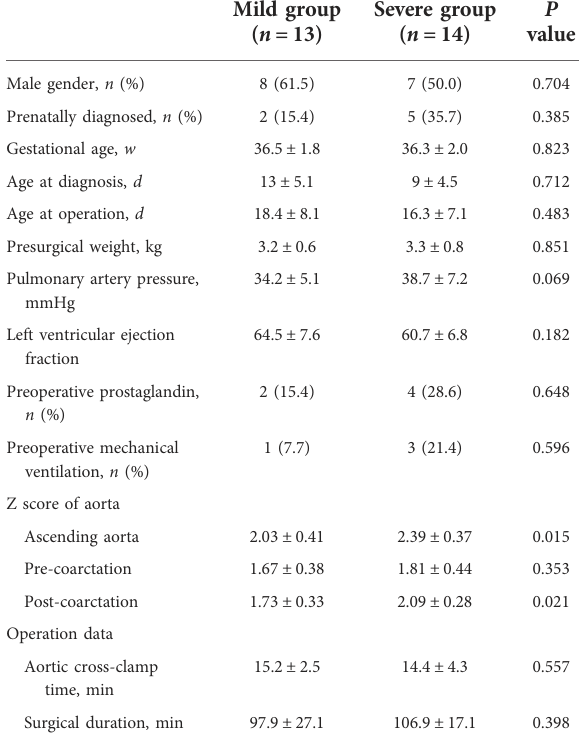
TABLE 1 Comparison of preoperative general clinical data between the two